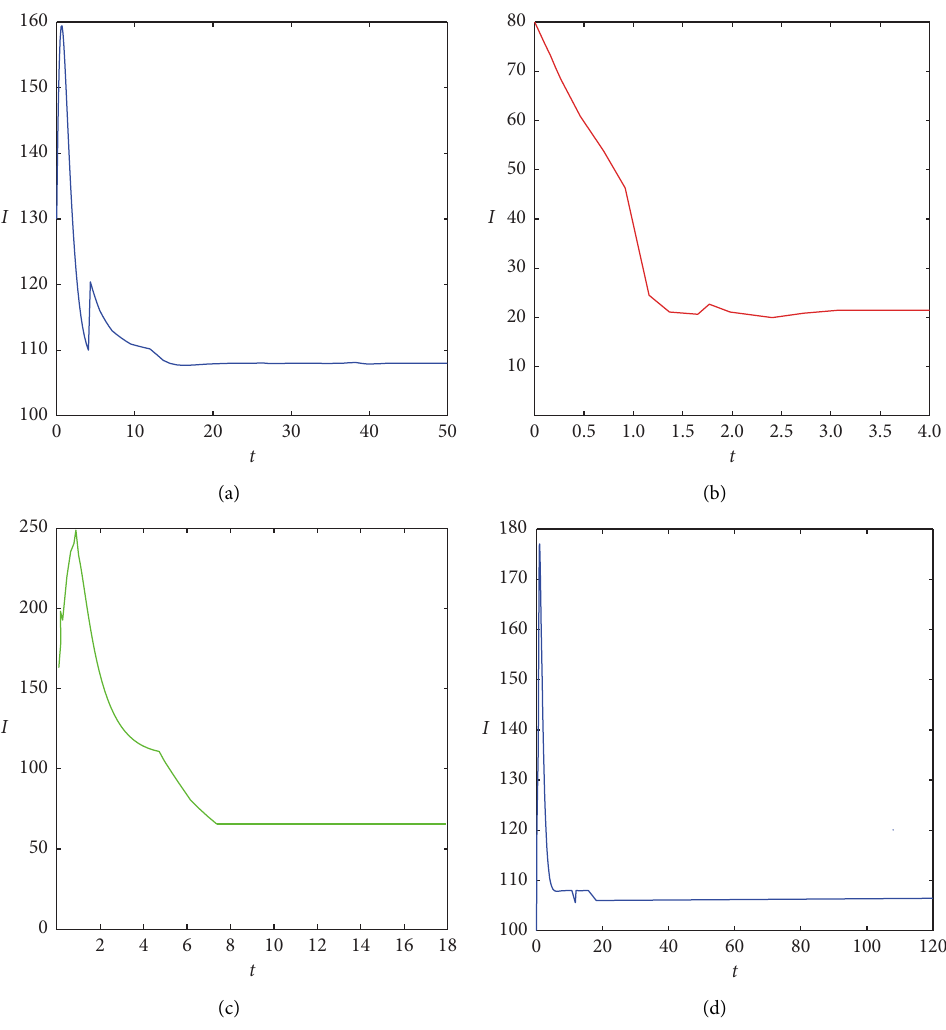
Figure 4: Time series of the infected animal populations with different initial values. Parameter